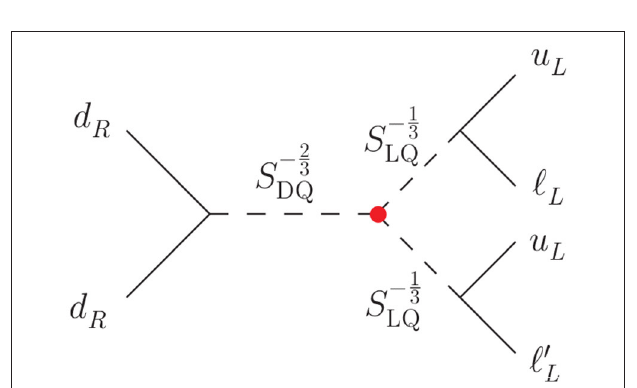
FIGURE 42 | L -violating processes at the LHC in the colored Zee-Babu model [